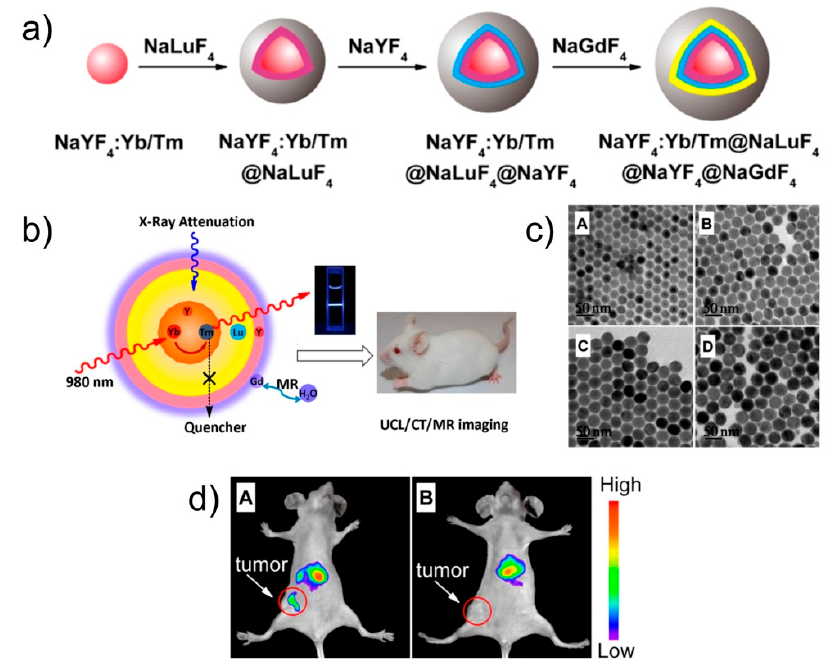
Figure 4. ( a ) Sketch showing the preparation of the multi-shelled NaYF 4 :Yb/Tm@NaLuF 4 @NaYF 4 @NaGdF 4 NPs. ( b ) Trimodal imaging potential of the nanoparticles. ( c ) TEM images of the nanoparticles at each step of preparation. ( d ) In vivo UCL imaging of Hela tumor-bearing nude mice at 3 h after intravenous injection of nanoparticles with (left) and without (right) folic acid functionalization. Adapted with permission from Anal. Chem. 2013 , 85 , 12166 − 12172 [59]. Copyright 2013 American Chemical Society.